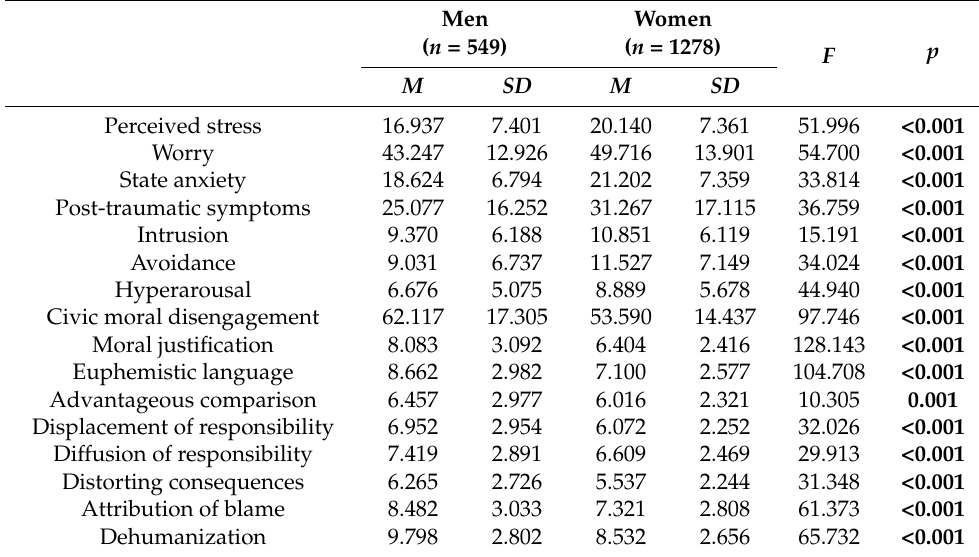
Table 4. Differences in psychological outcomes between men and women during the first year of COVID-19 pandemic in Italy.